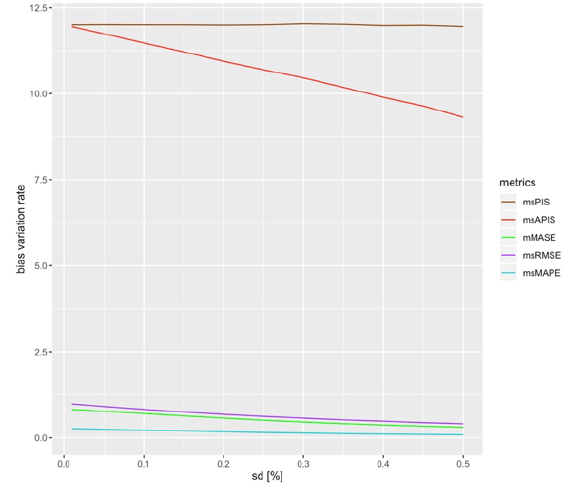
Figure 8. Bias variation rate in function of standard deviation.